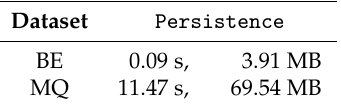
Table 2. Performance of F LAGSER computing